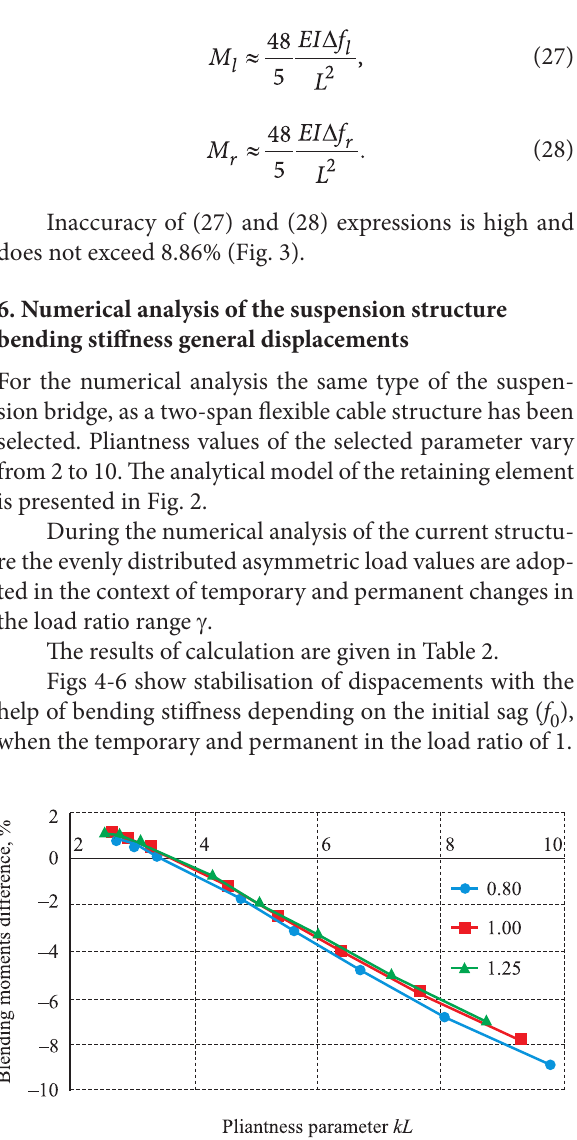
Fig. 3. Bending moments at the middle of the first span, differences of results calculated according to the engineering formulas and delivered by the program